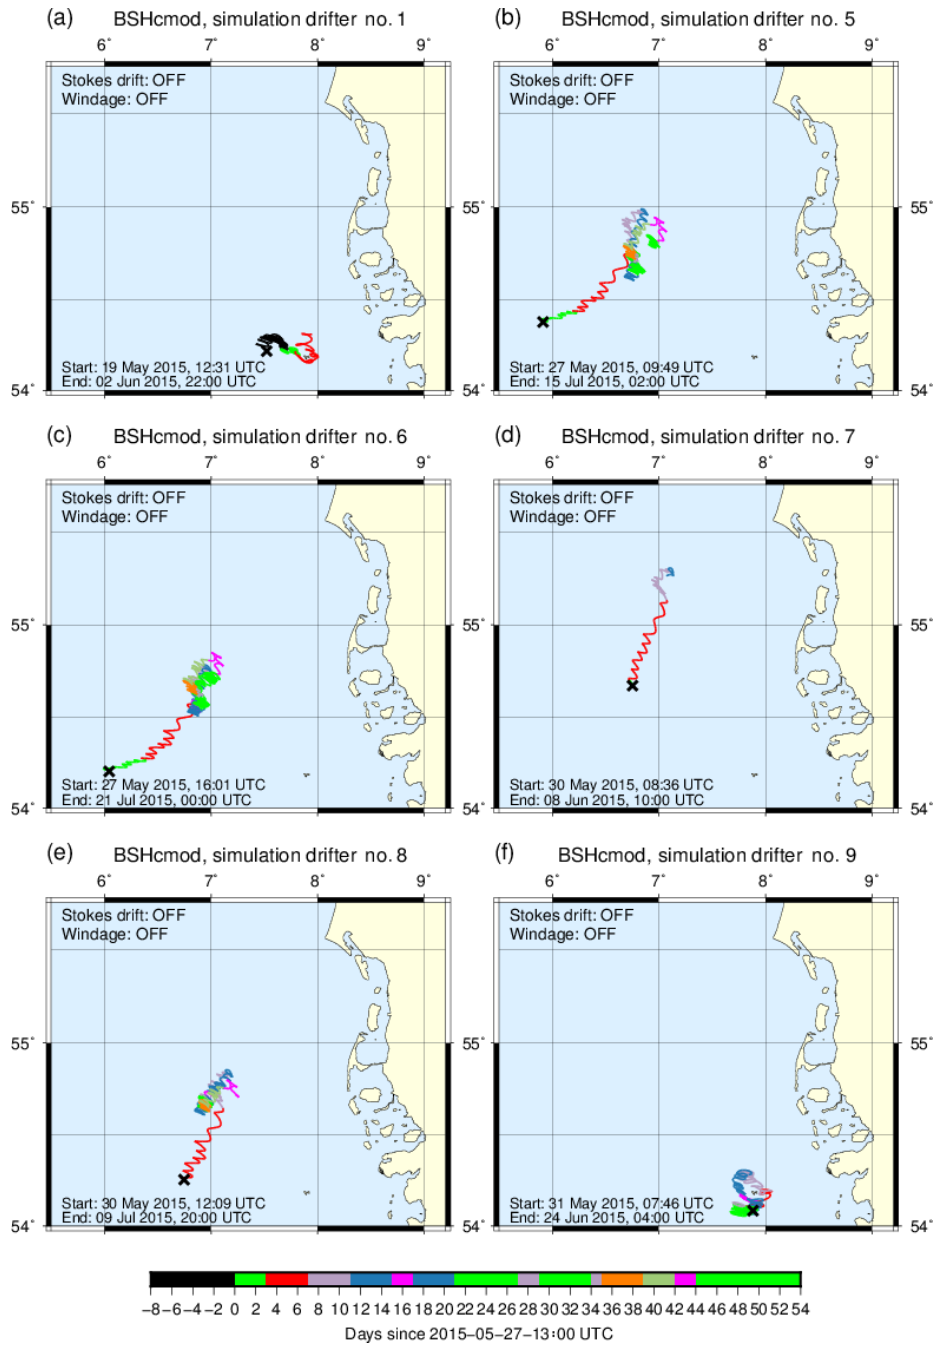
Figure A1. Simulations based on BSHcmod top-layer currents, disregarding extra effects of winds or waves. Black crosses indicate locations where simulations were